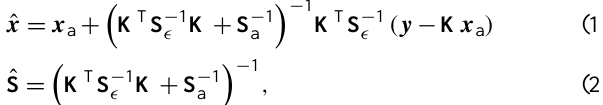
1 ) and CO 1 ) for the land regions ( TgCH ( GtCyear year − − 4 4 2